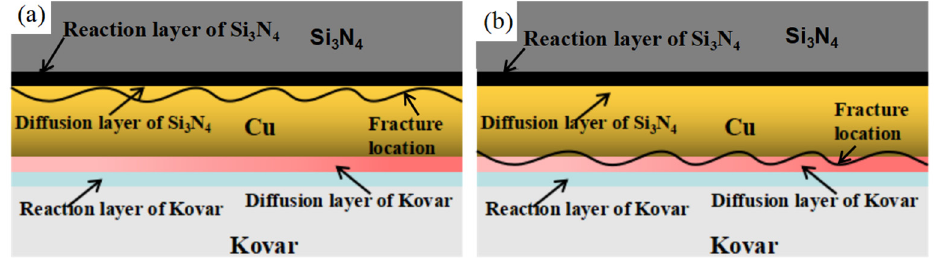
Figure 16. Schematic diagram of the fracture location of a typical Si 3 N 4 /Ti/Cu/Kovar joint: ( a ) As in Figure 15a, a schematic diagram of the fracture location of the joint; ( b ) as in Figure 15b, a schematic diagram of the fracture location of the joint.